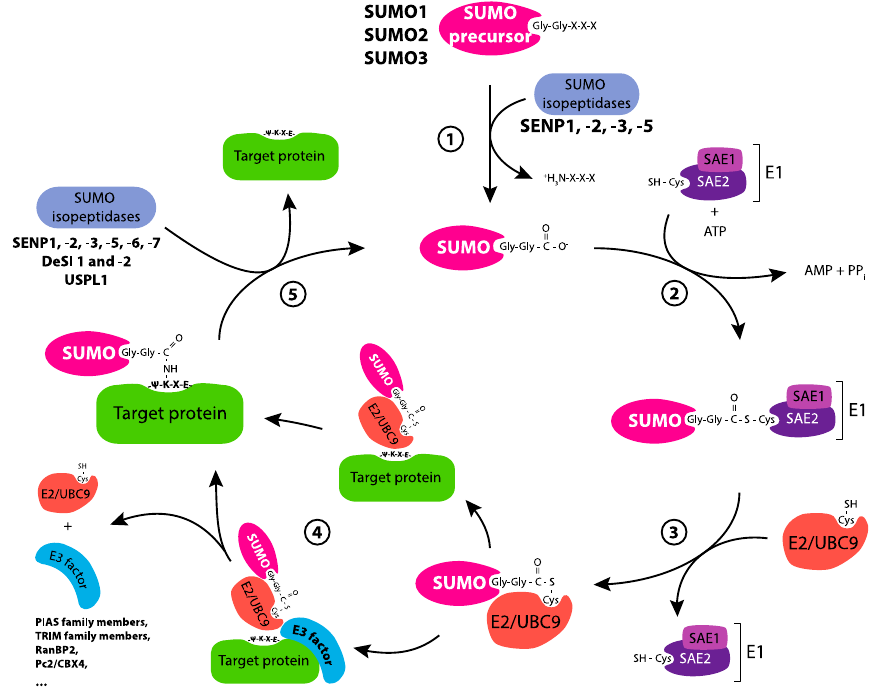
Figure 1. The SUMOylation cycle. The C-terminal extensions of SUMO-1, -2 and -3 precursors are removed by specific peptidases from the SENP family (SENP1, -2, -3 and -5, which also harbor isopeptidasic activities) to expose a C-terminal Gly-Gly motif essential for SUMO activation and, then, conjugation to protein substrates (1). SUMO is activated in an ATP-dependent manner via transfer to a reactive cysteine of the SAE2 subunit of the heterodimeric E1 SUMO-activating enzyme (2). This occurs in two steps. First, the SUMO GG motif is adenylated by the E1 enzyme. Then, full activation is obtained by transfer of the adenylated SUMO intermediate to the SAE2 reactive cysteine. Activated SUMO is then transferred to the reactive cysteine of the E2 SUMO-conjugating enzyme also called Ubc9 (3) and covalently coupled to the ε -NH 2 group of target lysines of protein substrates owing to an isopeptide bond. This can be achieved directly or with the help of SUMO E3 factors assisting the SUMO E2 enzyme (4) and often, but not always, occurs at a ψ KxE consensus motif (where ψ corresponds to a bulky hydrophobic amino acid and x to any amino acid). Some SUMO E3 factors are indicated but others probably remain to be discovered. Certain enzymes display an E4 elongase activity facilitating the formation of polySUMO chains (not represented). SUMO can be removed from its substrates and SUMO chains can be depolymerized by proteases showing SUMO isopeptidasic activity (5). These include the members of the SENP family as well as a few other enzymes such as DeSI-1 and -2 and